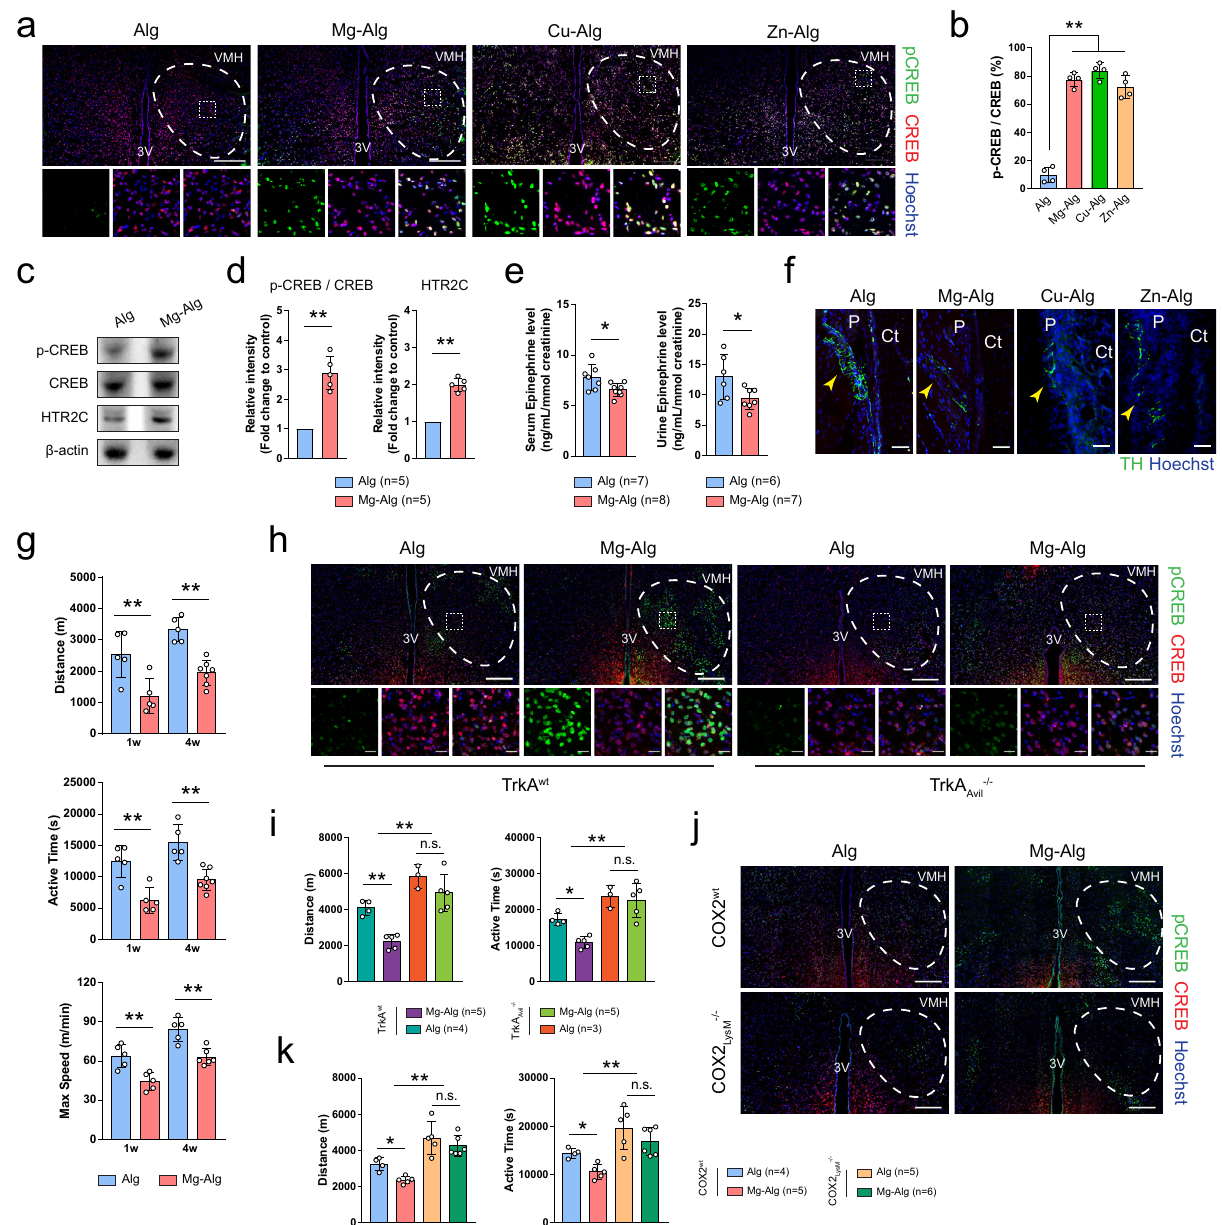
Fig. 5 Divalent cations downregulate sympathetic activity through hypothalamic CREB signaling. Representative immuno fl uorescent images ( a ) and corresponding quanti fi cation ( b ) showing the phosphorylation of CREB in the ventromedial hypothalamus (VMH) 1 week postoperatively ( n = 4). Lower images (scale bars = 20 µ m) are high-resolution versions of the boxed regions in the upper images (scale bars = 200 µ m). Representative Western blots ( c ) and corresponding quanti fi cation ( d ) showing the phosphorylation of CREB and the expression of 5-hydroxytryptamine receptor 2C (HTR2C) in the hypothalamus tissue of mice at week 1 postoperatively. e ELISA of serum and urine epinephrine levels of mice at week 1 postoperatively. f Representative immuno fl uorescent images showing the presence of tyrosine-hydroxylase + (TH + ) sympathetic fi bers on cortical bone surface ( n = 3, scale bars = 50 µ m). g The daily distance (m), duration (s), and maximum speed of running-wheel activity of WT mice at weeks 1 and 4 postoperatively ( n = 5). Representative immuno fl uorescent images showing the phosphorylation of CREB in the VMH of TrkA wt or TrkA Avil − / − mice ( h ), as well as COX2 wt or COX2 LysM − / − mice ( j ) at week 1 postoperatively ( n = 3). Lower images (scale bars = 20 µ m) are high-resolution versions of VMH regions in the upper images (scale bars = 200 µ m). The daily distance (m) and duration (s) of running-wheel activity of TrkA wt mice or TrkA Avil − / − ( i ), as well as COX2 wt or COX2 LysM − / − ( k ) mice at week 4 postoperatively. Data are mean ± s.d. * P < 0.05, ** P < 0.01 by Student ’ s two-sided T-test ( d , e ), two-way ANOVA with Tukey ’ s post hoc test ( g ), or 1-way ANOVA with Tukey ’ s post hoc test ( b , i , k ). Source data are provided as a source data fi Knockout of EP4 in the sensory nerve inhibits divalent cation- on decreasing the daily distance and duration of running-wheel induced activation of skeletal interoception . EP4 is the PGE 2 activity was diminished in COX2 LysM − / − mice (Fig. 5k). Taken receptor in the skeletal interoception and is known as the primary together, our data show that divalent cations promote PGE 2 from macrophages to activate skeletal interoception, resulting in receptor in bone remodeling and homeostasis 47 . We fi rst pre- downregulation of sympathetic tone and new bone formation. pared conditional medium from Mg 2 + -treated macrophages to